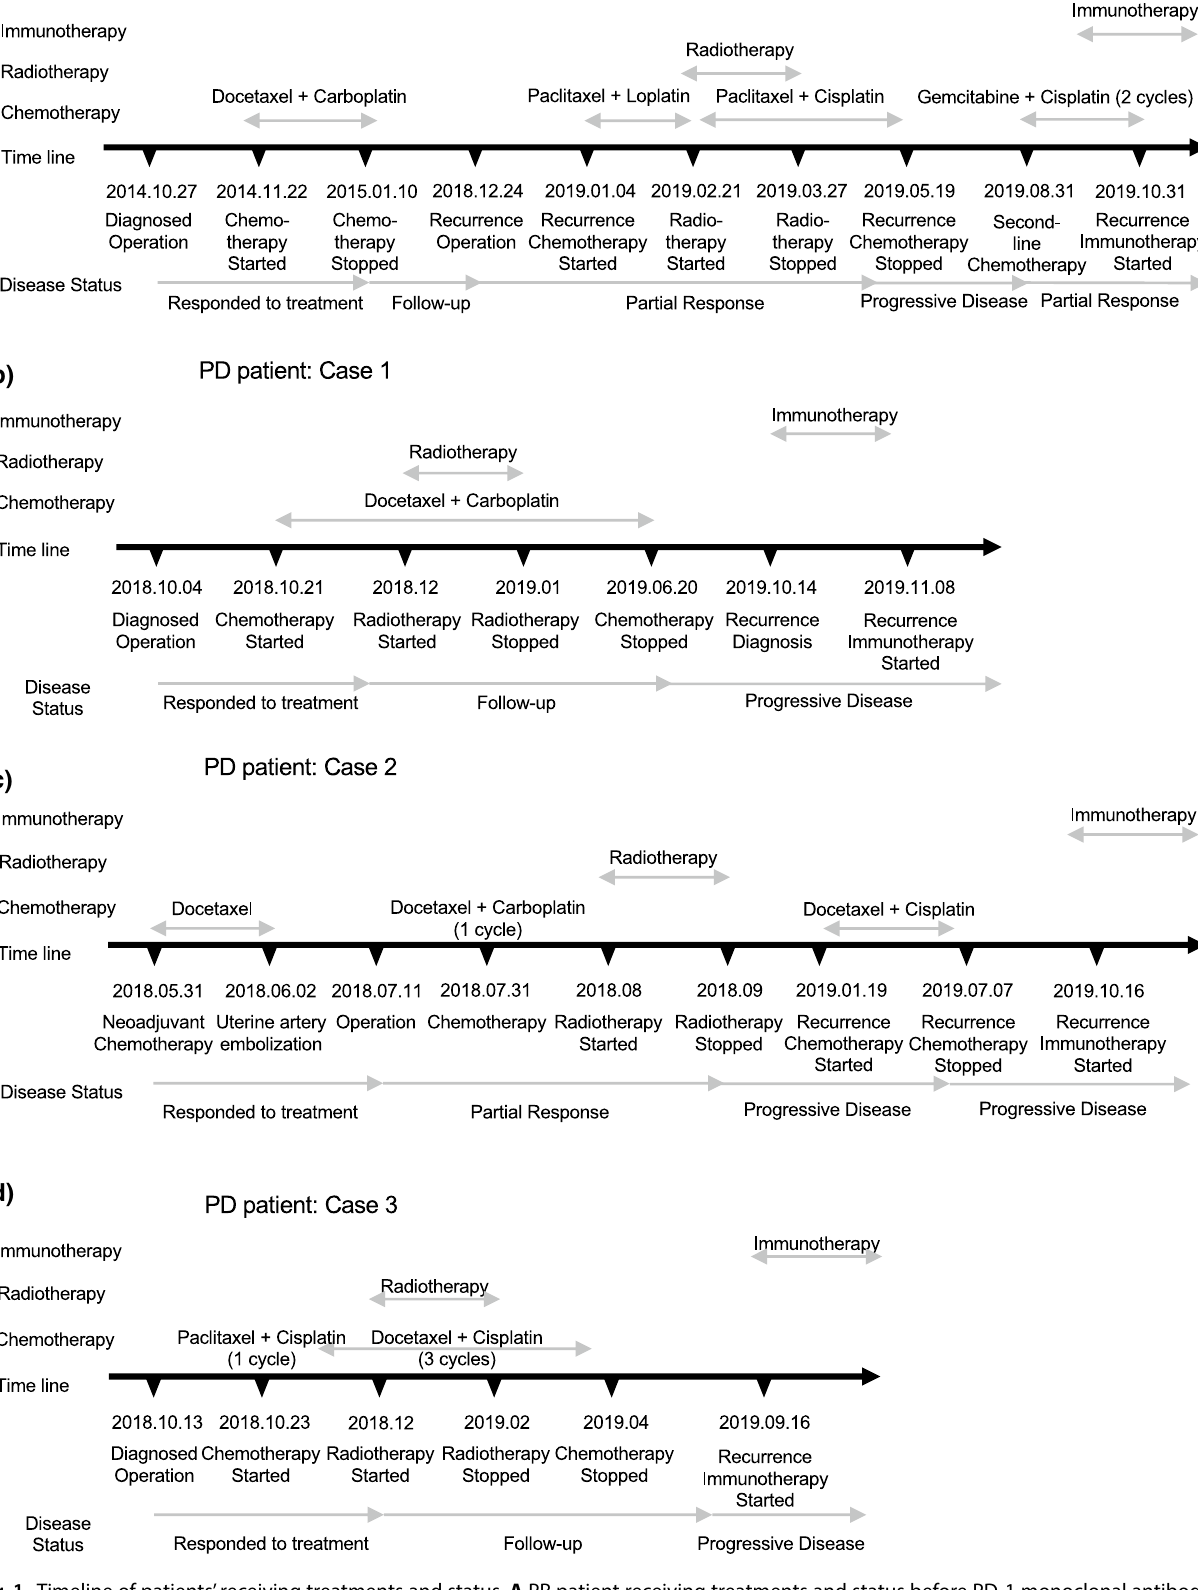
Fig. 1 Timeline of patients’ receiving treatments and status. A PR patient receiving treatments and status before PD-1 monoclonal antibody therapy (Patient 4). B – D PD patient receiving treatments and disease status before PD-1 monoclonal antibody therapy (Patient